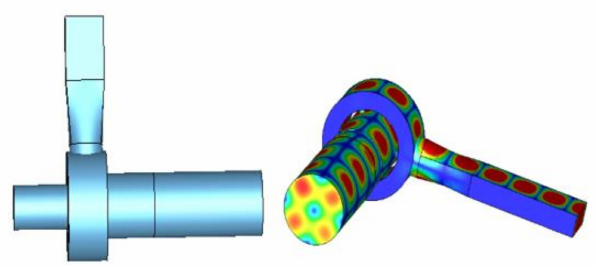
Figure 3. Coupler structure and field distribution diagram.